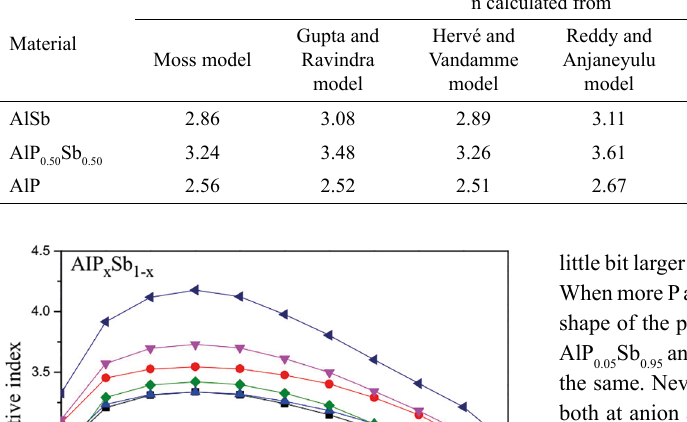
Sb and AlP semiconductor materials calculated using six models. 0.50 0.50